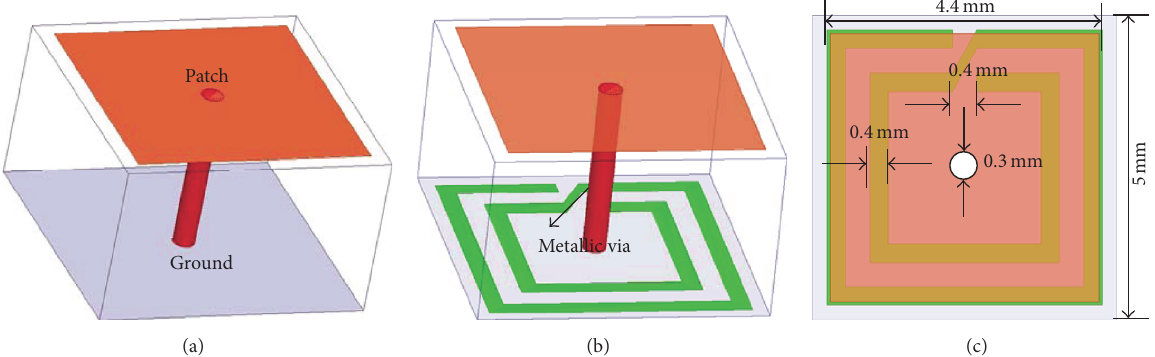
Figure 1: Topology of the conventional mushroom and CSRs-loaded mushroom structures. Perspective of (a) conventional mushroom cell and (b) CSRs-loaded mushroom element; (c) top and bottom view of the CSRs-loaded mushroom unit as well as geometrical dimensions.